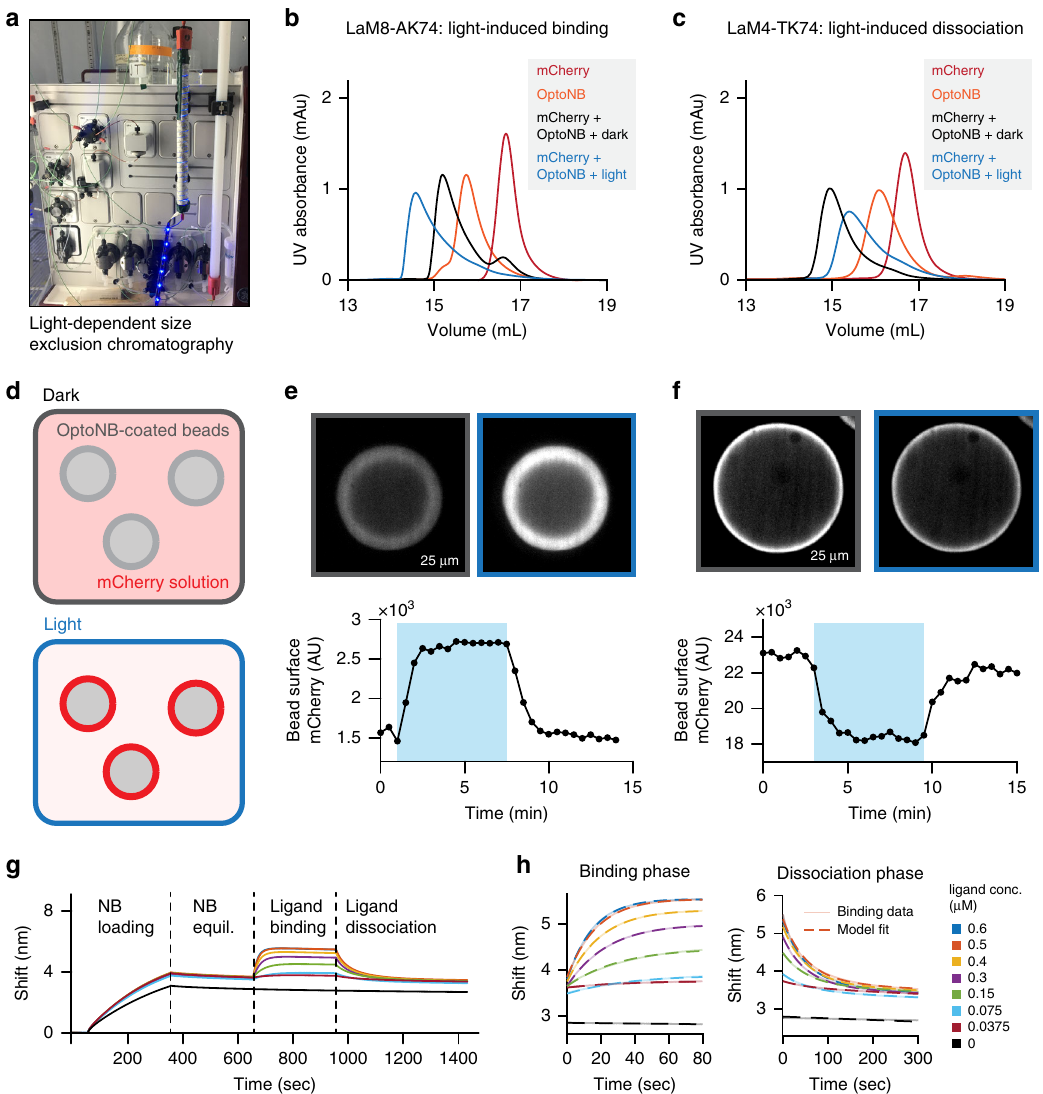
Fig. 4 In vitro characterization of OptoNB binding. a Size exclusion chromatography (SEC) for light-dependent protein separation. The column was wrapped with 450 nm blue LEDs to allow for direct illumination of the protein during the SEC run, or in aluminum foil to keep it in darkness. b , c SEC elution pro fi le for LaM8-AK74 (in b ) and LaM4 TK74 (in c ) in light conditions; for additional runs in the light and dark see Supplementary Fig. 4a, b. Free mCherry, free OptoNB, and dark- and light-incubated OptoNB/mCherry mixtures are shown in the indicated curves. Shorter retention times indicate larger size and increased complex formation. d Schematic representing light-induced binding of mCherry to OptoNB-coated beads. His-tagged OptoNBs are immobilized on Ni-NTA agarose beads, while untagged mCherry is in the buffer solution surrounding the beads. A change in illumination conditions results in mCherry- OptoNB binding and a brighter bead surface in the mCherry channel. e , f Top panels: confocal mCherry images of beads coated with a mixture of His- tagged EGFP with His-tagged LaM8-AK74 in a 200:1 ratio (in e ) or LaM8-GG15 in a 1000:1 ratio (in f ). Beads were placed in 1 μ M mCherry solution (in e ) or 2 μ M mCherry solution (in f ). A 450 nm LED was toggled on and off (blue shading indicates LED illumination). Bottom panels: quanti fi cation of bead surface intensity during cycles of darkness and blue light illumination. Images are representative of three replicate experiments. g Representative bio-layer interferometry (BLI) traces for quantifying nanobody-protein binding and dissociation kinetics. Four phases indicate His-tagged OptoNB loading onto the Ni-NTA coated tips, equilibration in buffer, binding to different concentrations of soluble mCherry, and mCherry dissociation into buffer. h Raw data (solid lines) and best- fi t traces simultaneously fi t to simple mass-action kinetic binding model (dashed lines) are shown for the immobilized LaM8 nanobody binding to soluble mCherry at eight concentrations. Source data are available as a Source data fi